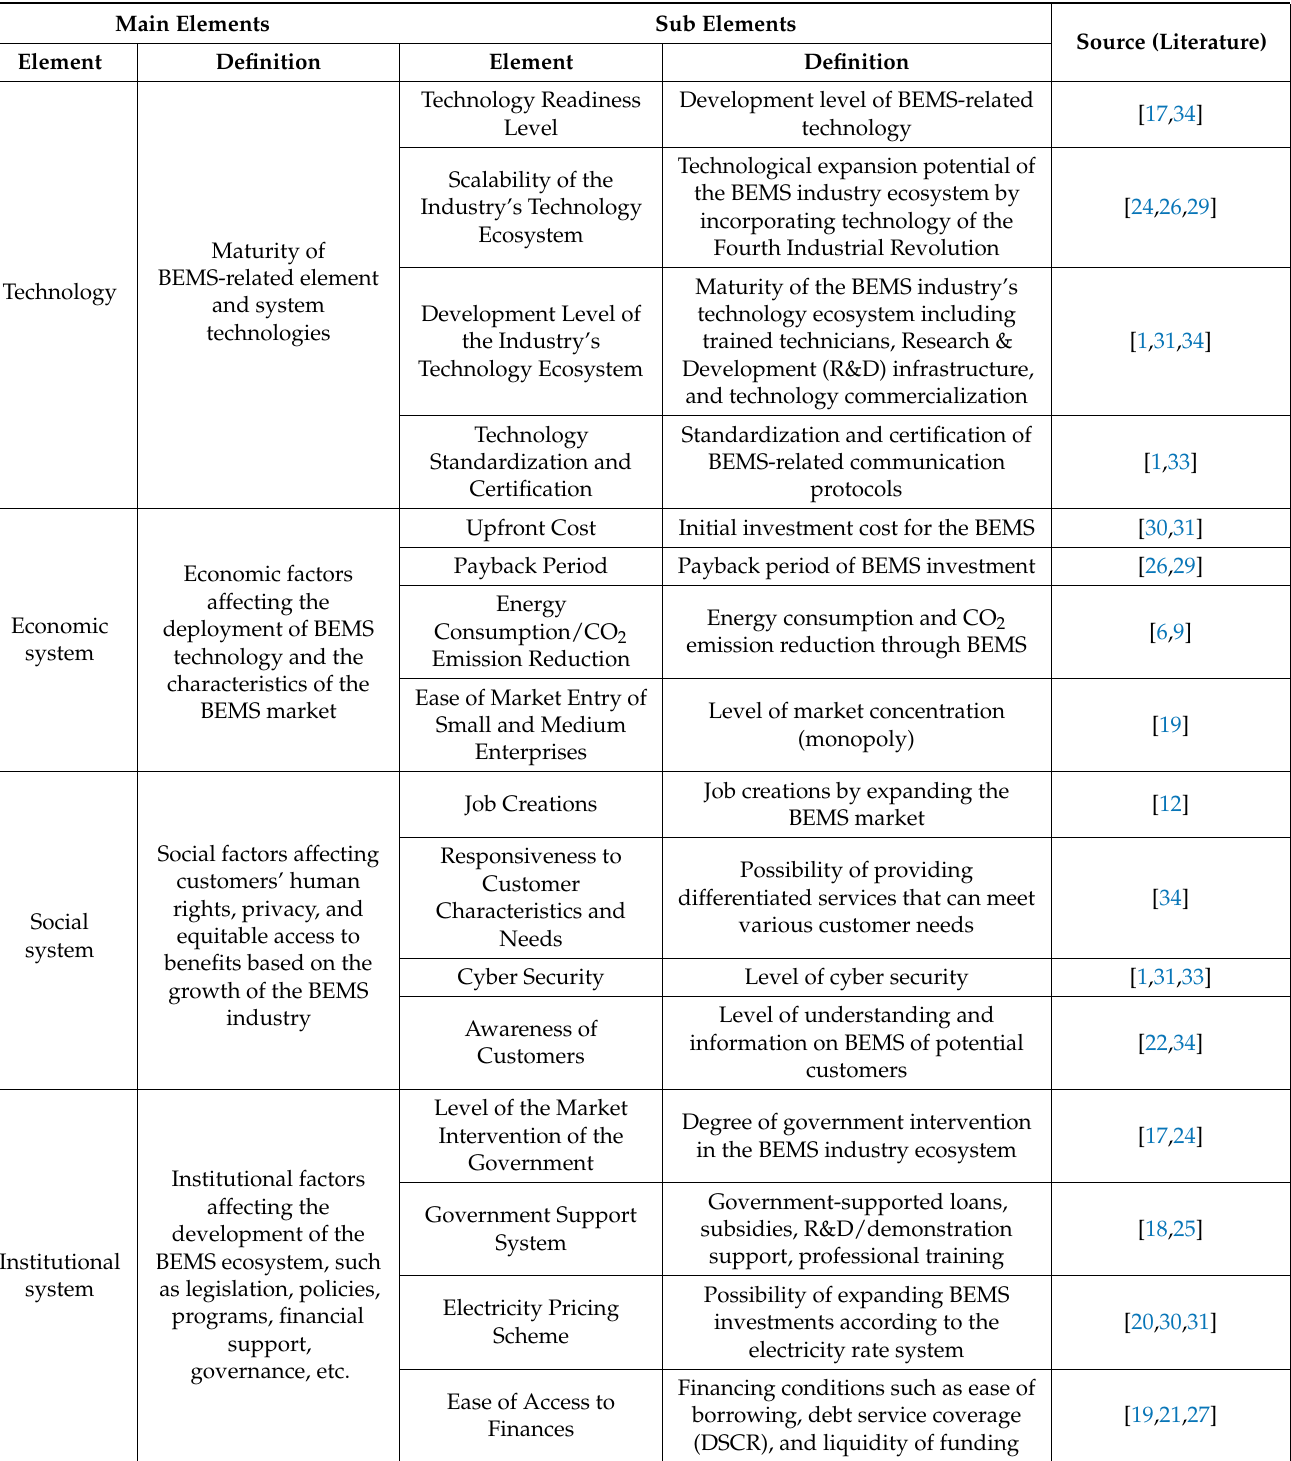
Table 1. Elements of the BEMS industry ecosystem and